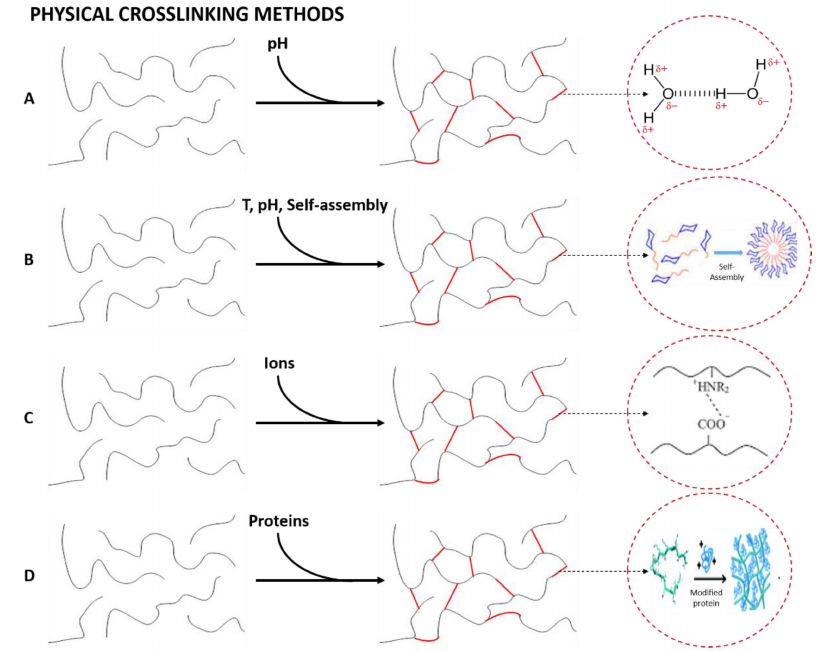
Figure 4. Formation of physically cross-linked hydrogels by ( A ) hydrogen bonding, ( B ) amphiphilic grafts and block polymers, ( C ) ionic interactions and ( D ) protein